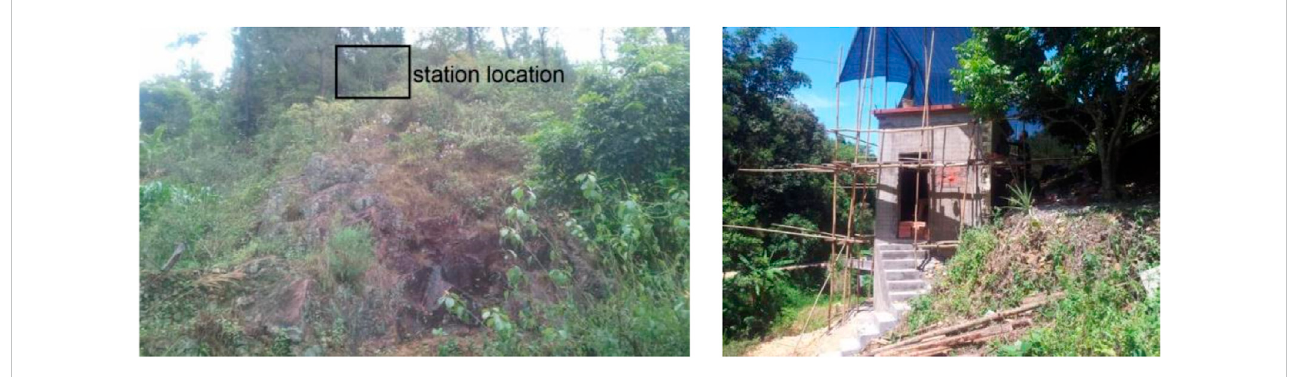
FIGURE 5 Site conditions and working environment of FSLHX station.